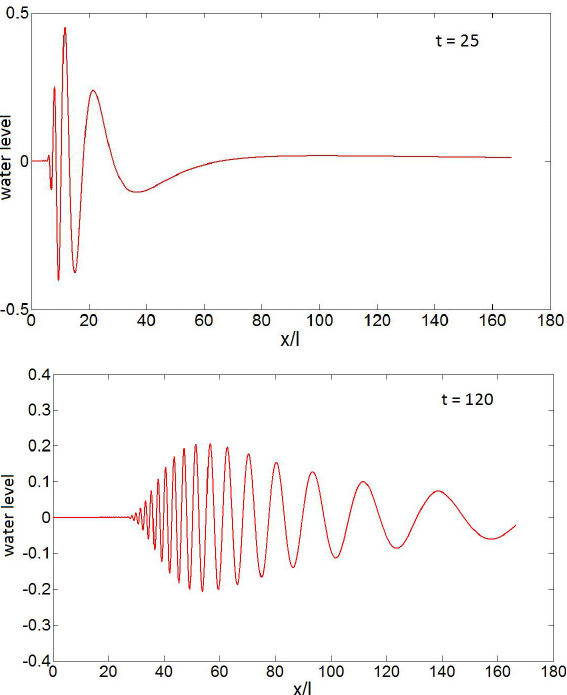
Fig. 1. Evolution of the Gaussian pulse in deep water for long times.